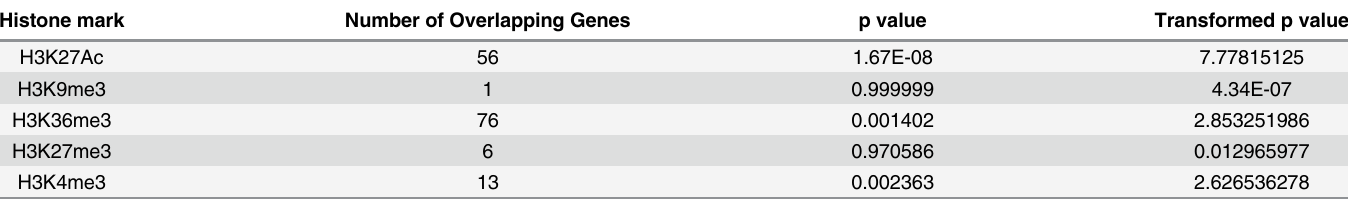
Table 1. Statistical association of the most significantly enriched nearest genes for insertions and histone marks. The number of overlapping genes from the top 500 are noted, as are the p values for significance of overlap. Note that the p value for H3K27ac represents a 1 in 60x10 6 chance of the associa- tion occurring by chance, but the true p value will be lower as this level of overlap was not observed in 60x10 6 simulations. Histone mark Number of Overlapping